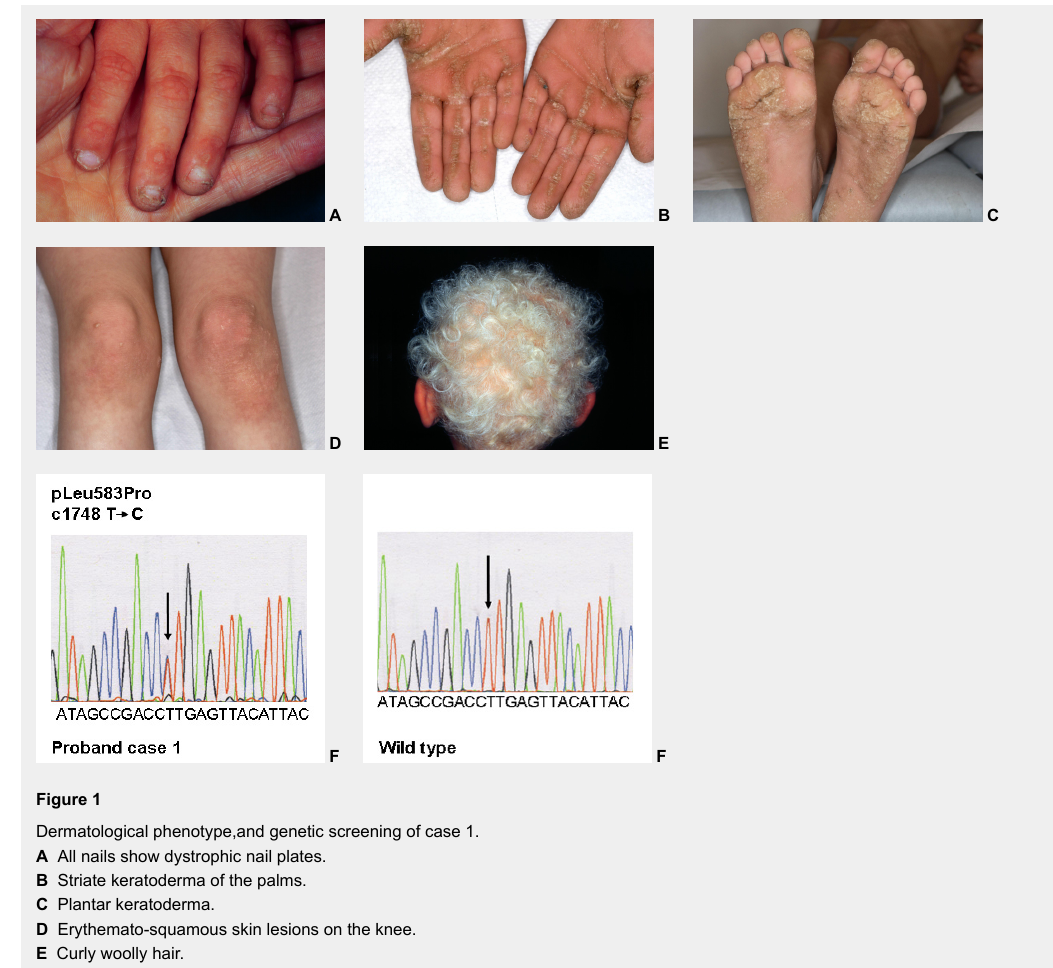
Figure 1 Dermatological phenotype,and genetic screening of case 1. A All nails show dystrophic nail plates. B Striate keratoderma of the palms. C Plantar keratoderma. D Erythemato-squamous skin lesions on the knee. E Curly woolly hair. F Electropherograms of the desmoplakin mutation and of the wild type: a heterozygous variant in DSP , c.1748 T>C, was identified, resulting in the missense mutation p.Leu583Pro at a heterozygous